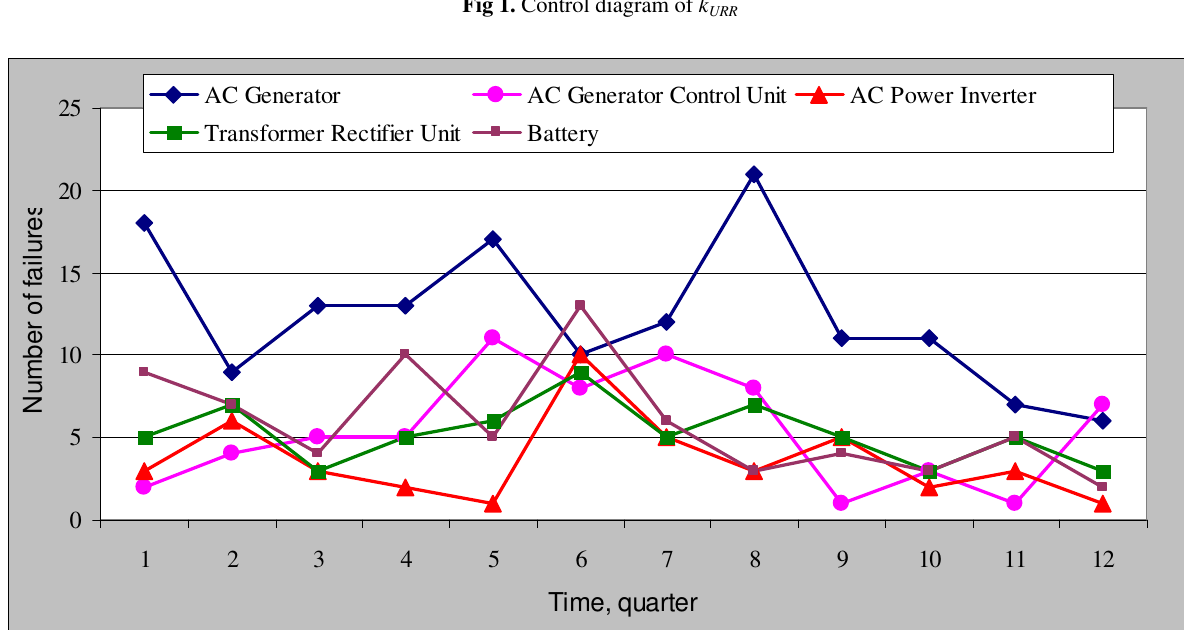
Fig 1. Control diagram of k URR